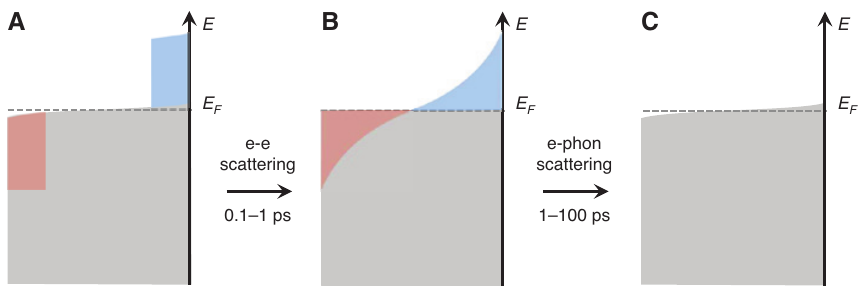
Figure 2: The heating and cooling of the electron gas. (A) The electron (blue) and hole (red) populations near the Fermi level after Landau damping of the coherent surface plasmon oscillations. (B) The redistribution of energy due to the electron-electron scattering, forming a thermalized Fermi-Dirac distribution of the joint electron-hole states on the 0.1–1 ps timescale. (C) Electron-phonon scattering transfers to the lattice. This leads to cooling of the electron temperature on the 1–100 ps